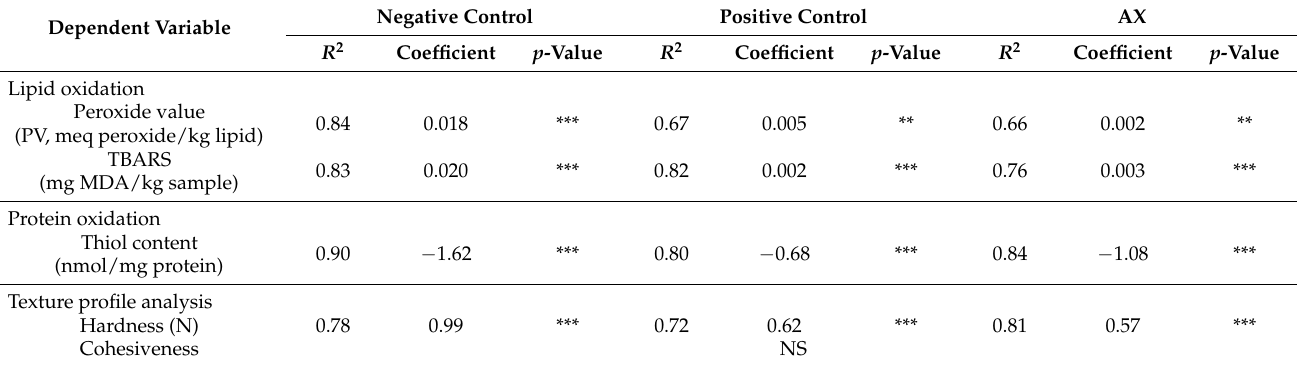
Table 4. Linear regression of lipid and protein oxidation and textural properties of emulsified sausages with different antioxidants during cold